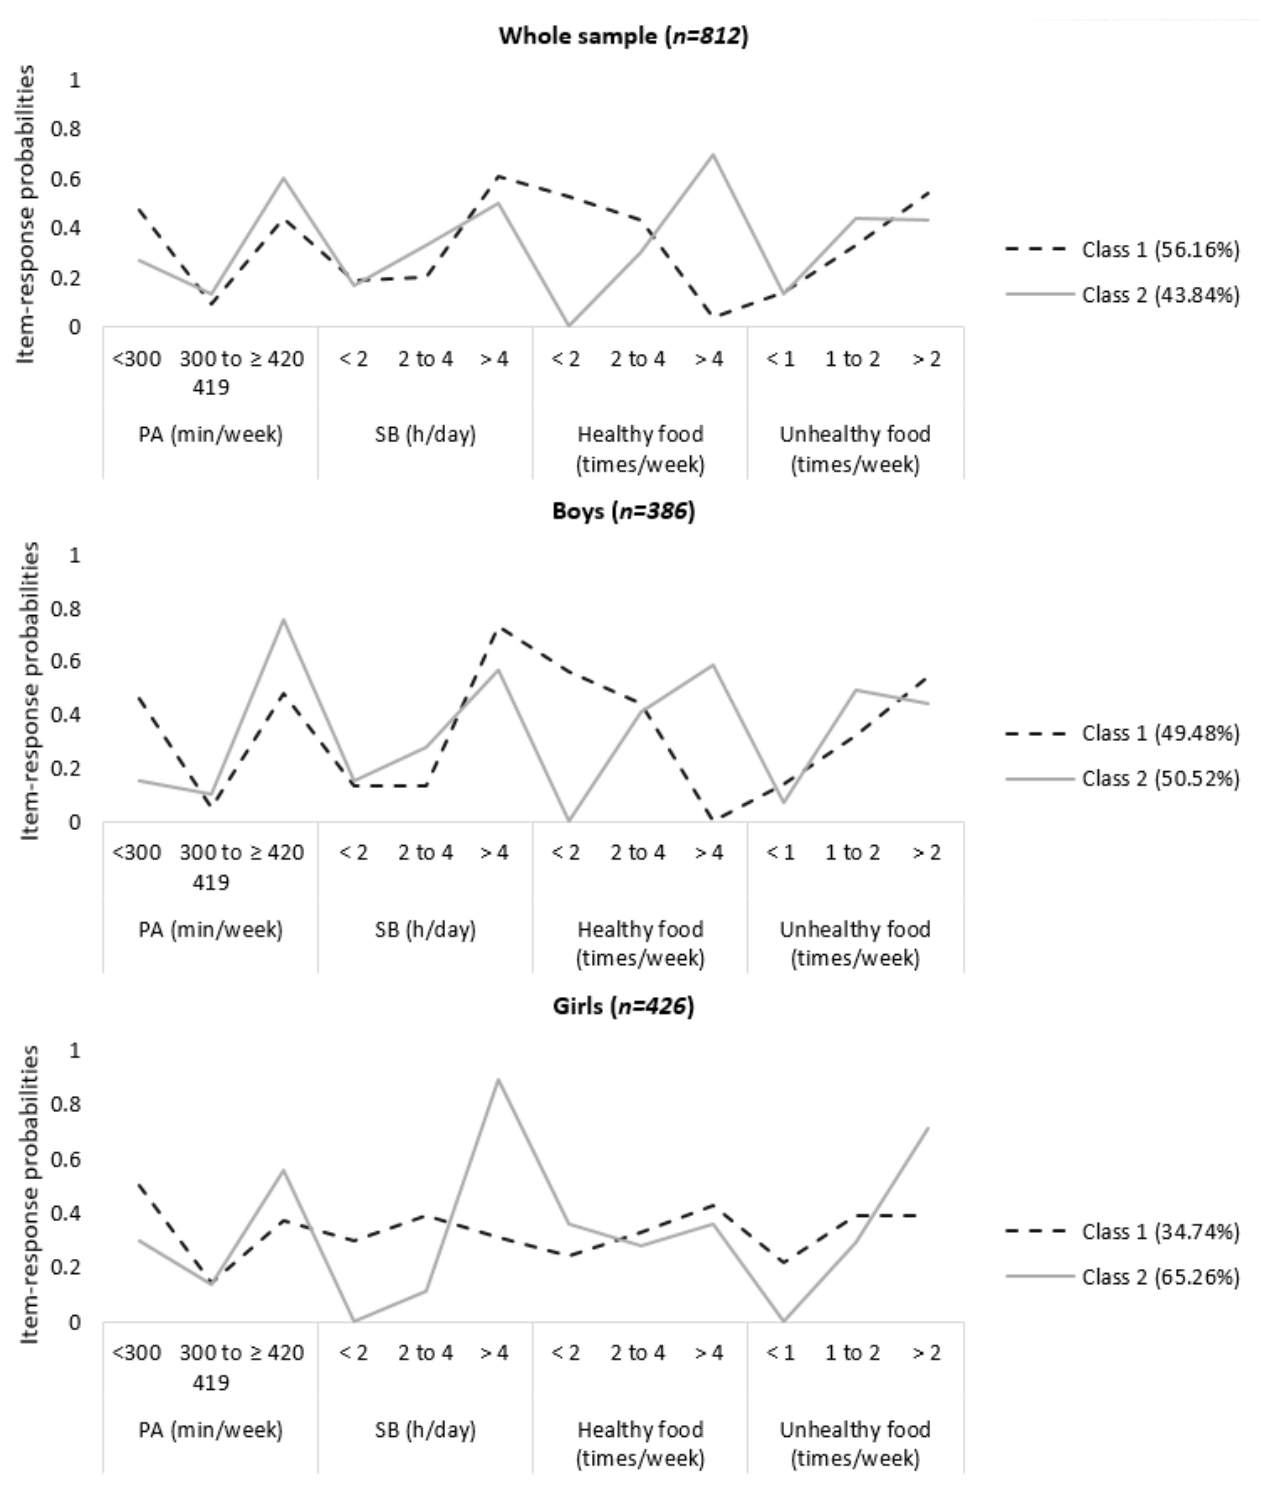
Figure 1. Prevalence and item-response probabilities of each risk behavior for each class in Brazilian adolescents. Note: PA: physical activity; SB: sedentary behavior. Healthy food: fruit and vegetables. Unhealthy food: sugar, salt and soda.